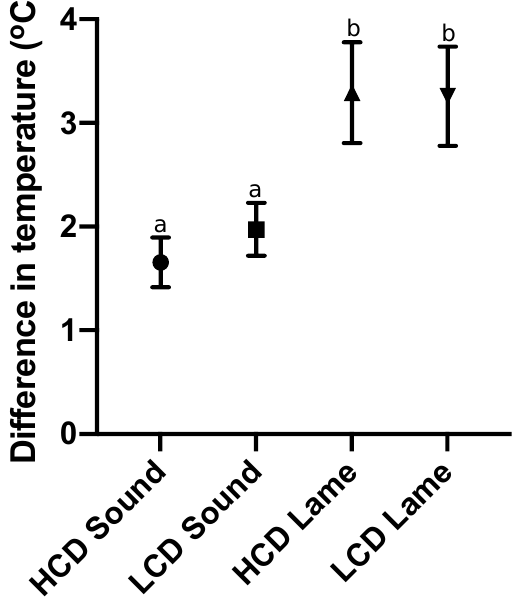
Figure 7. A graph showing the mean and 95% confidence interval of the temperature difference between the hind feet of each individual cow, for the categories of lame and sound cow (n = 203 and 118, respectively; both the devices used had an equivalent n in corresponding groups); these were determined by mobility scores of 0 and 1 being classed as sound, and mobility scores of 2 and 3 being classified as lame. This graph shows both the data set obtained from the CAT S62-Pro Smartphone (LCD) and that from the FLIR T620bx (HCD). ab different superscripts indicate significant differences between means at p < 0.05.